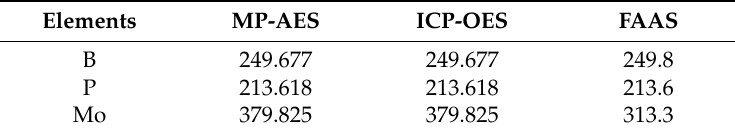
Table 3. Characteristic wavelength (nm) for MP-AES, ICP-OES, and FAAS.